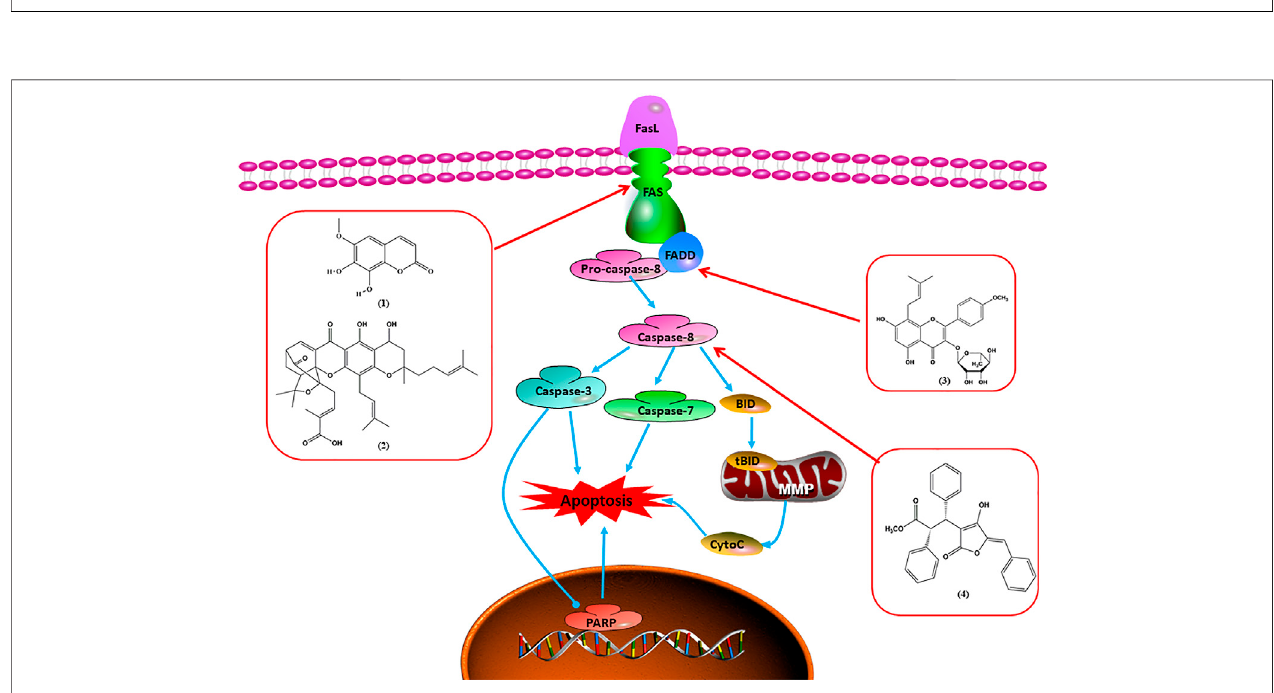
FIGURE 2 | Natural products induced apoptosis through FasL-Fas pathway. (1) Fraxetin, (2) gambogenic acid, (3) icariside II, (4) pulveraven A.